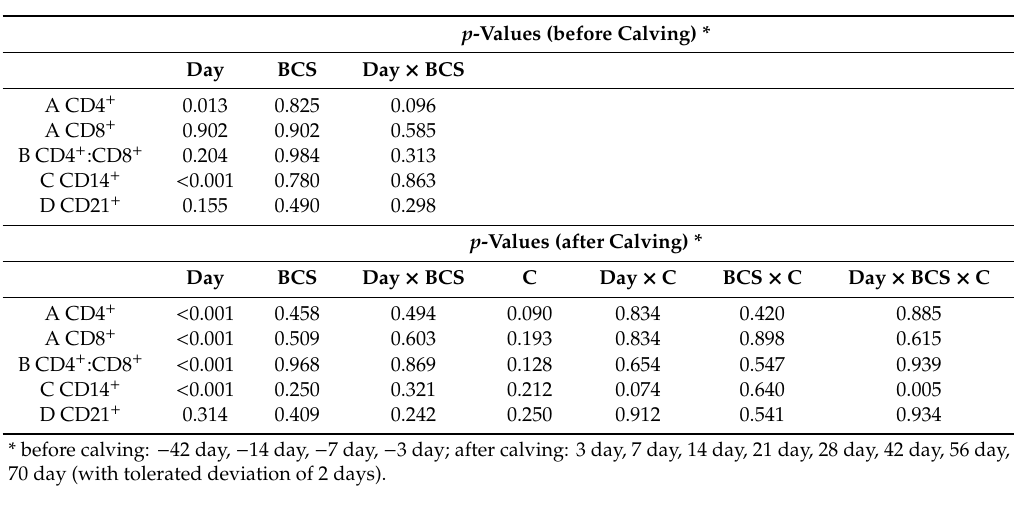
Table 3. Model corresponding to Figure 4.